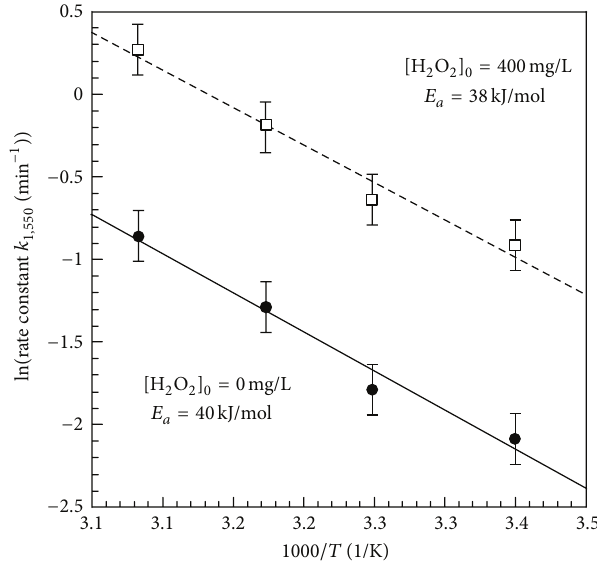
Figure 9: Arrhenius plot of the apparent rate constant of the RhB (10.2mg/L) decoloration, assuming a pseudo, first, order reaction, with (open squares) and without (filled circles) hydrogen peroxide (400mg/L). The apparent activation energy was calculated from the angular coefficient of the linear fitting